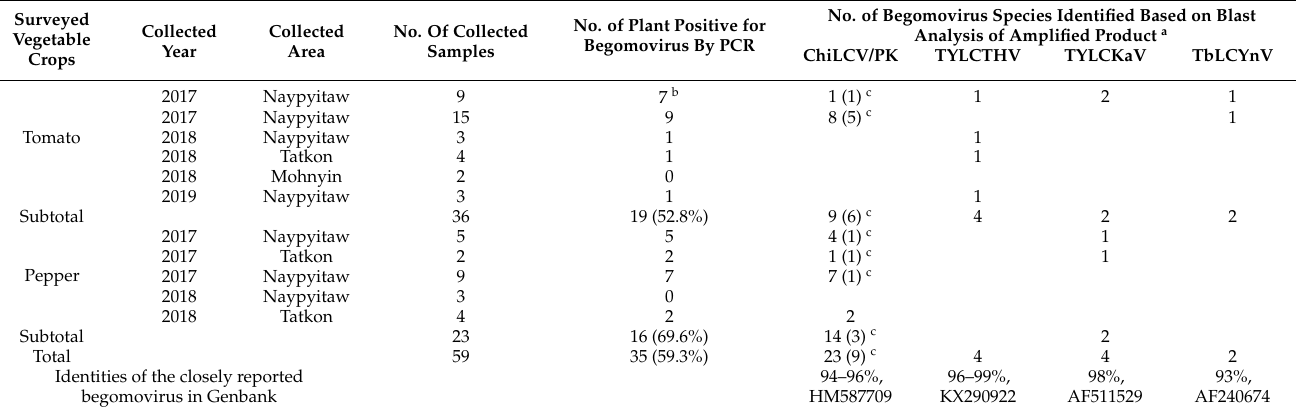
Table 1. Tomato and pepper plants collected from Myanmar and detection of begomovirus.